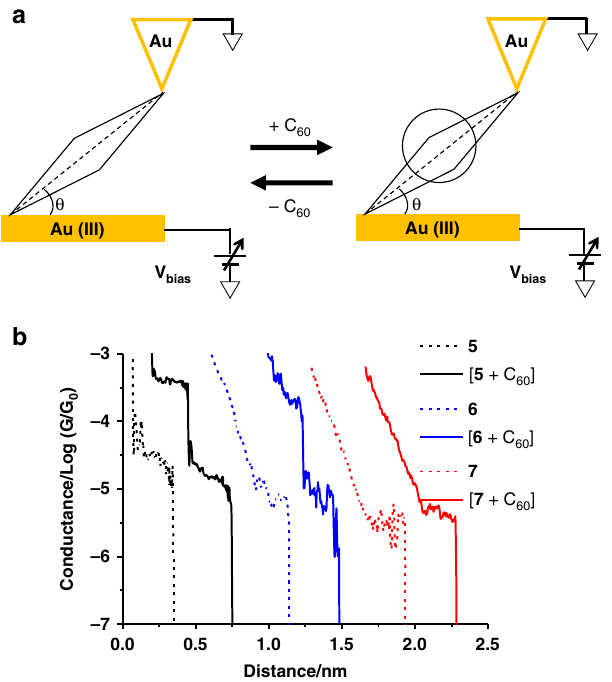
Fig. 2 Conductance vs. distance traces for metallocycles and their host – guest complexes with C 60 . a Schematic view of molecular junction ( θ ≈ 50°). b Representative conductance vs. distance traces of 5 , 6 , 7 , and